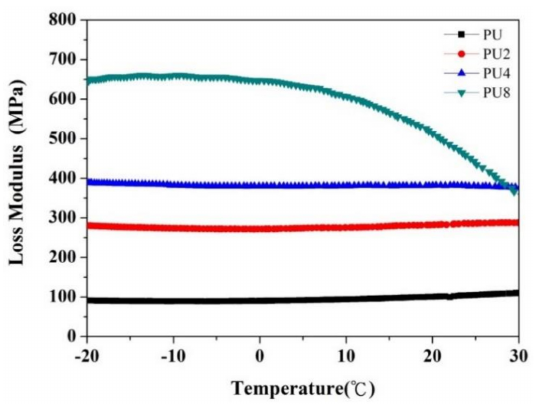
Figure 10. Loss moduli of PU coating and PU/Gr composite